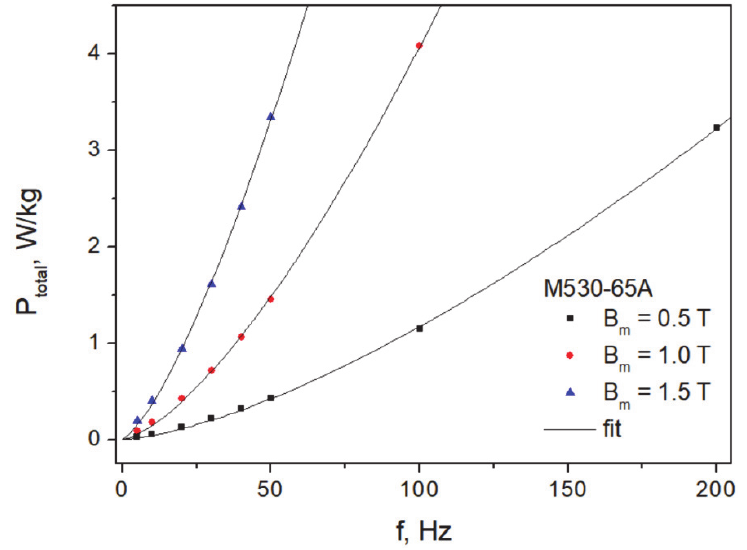
Figure 13. Measured and modeled P total = P total (f) dependencies for the M530-65A steel. Fit was Figure 12. Measured and modeled P total = P total (f) dependencies for the M530 ‐ 65A steel. Fit was car ‐ carried out using a fixed value of coefficient in the power law for dynamic ried out using a fixed value of coefficient in the power law for dynamic loss.